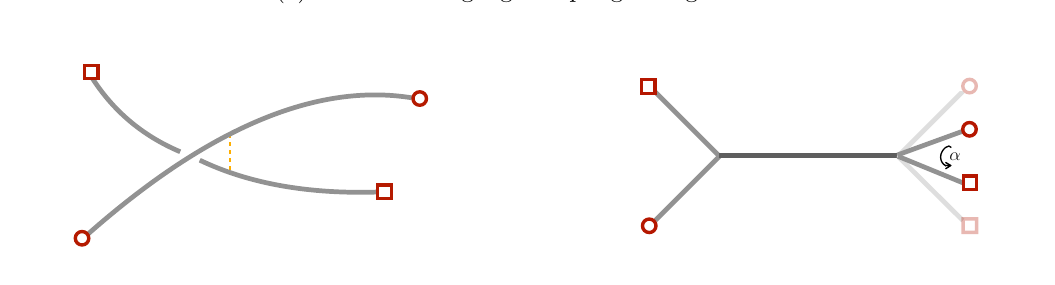
Figure 3 . Phase diagram of softly broken E 1 theory for positive described by pure SU(2) YM at low energy and enjoys a U(1) dashed region is a symmetry broken phase, U(1) transition occurs. The SU(2) YM effective gauge coupling diverges there.